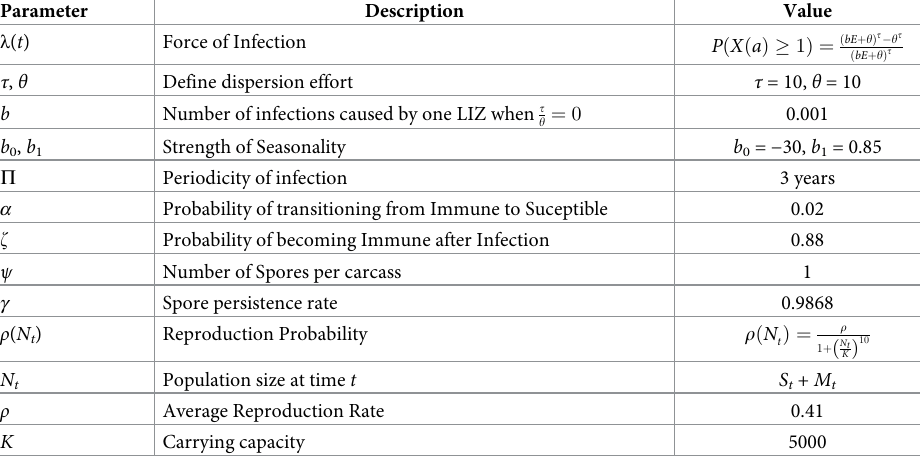
Table 1. Parameters considered in the SMILE model and their description. The values described in the Value col- umn correspond to the values used during simulations and in the cases in which the parameters are functions, the equation is